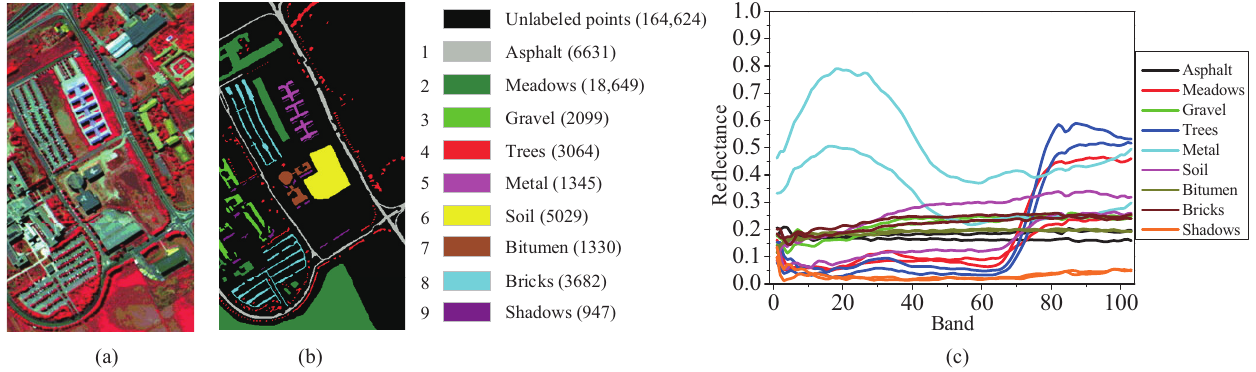
Figure 2. PaviaU hyperspectral image. ( a ) False color image. ( b ) Ground truth. ( c ) Spectral curves. (Note that the number of samples for each class is shown in brackets).